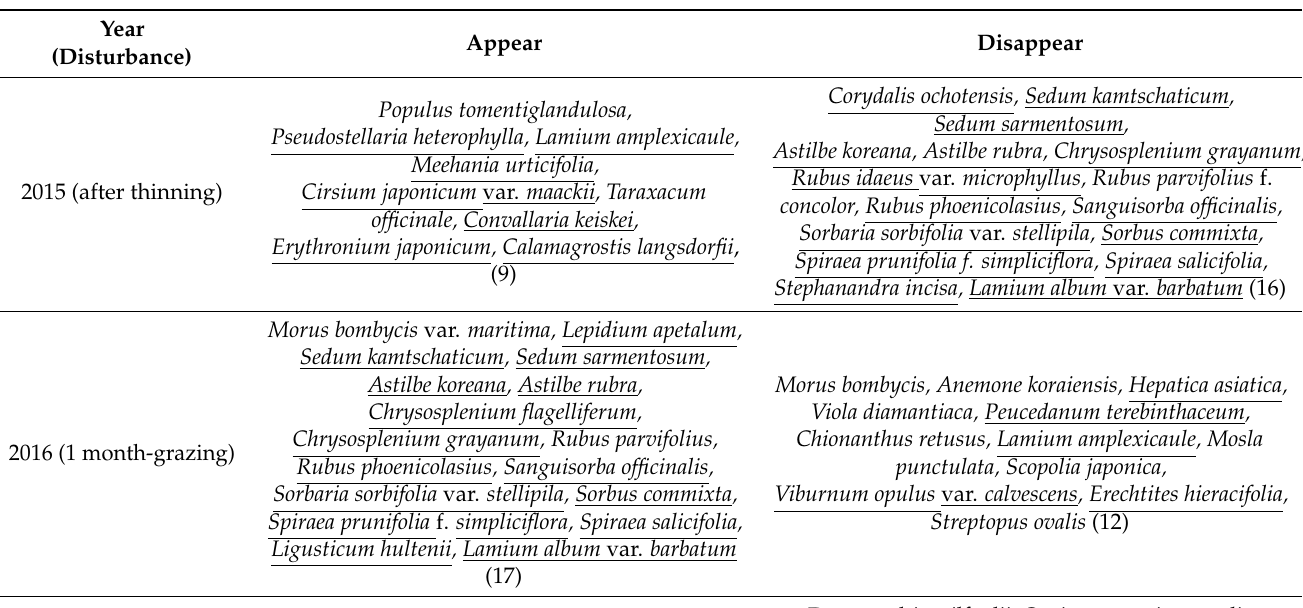
Table 4. Changes in floral composition in the study area by year and the disturbances. Underlined species disappeared once and revived 1 or 2 years later; bold species disappeared and never returned; bold and underlined species were newly observed and then disappeared 1 or 2 years